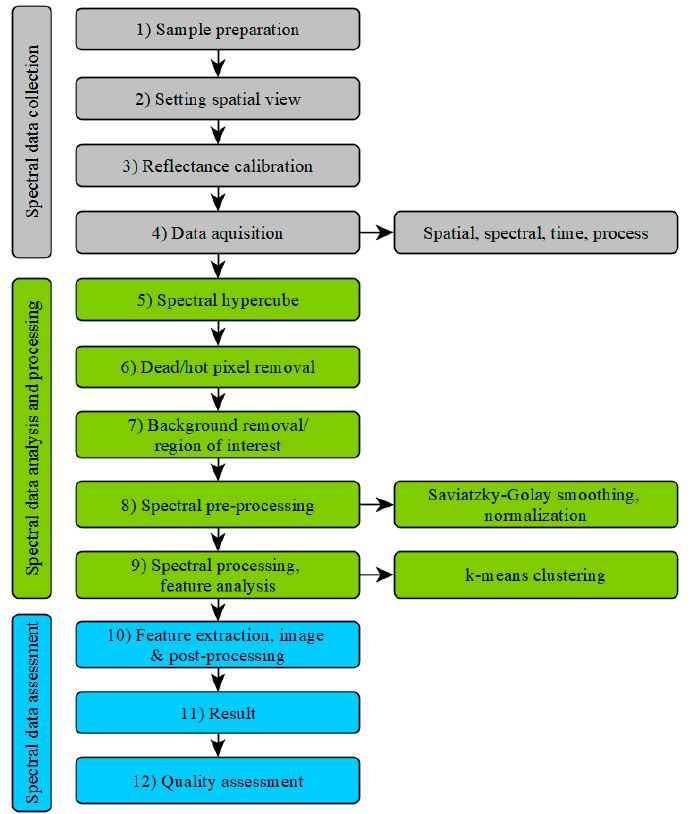
Figure 3. Hyperspectral imaging process steps.